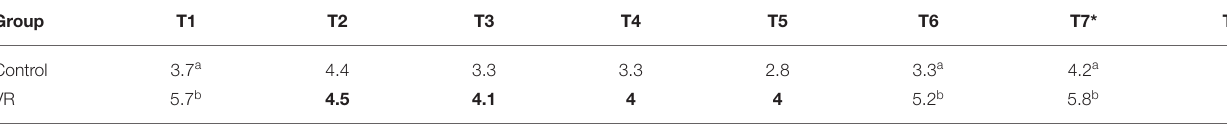
TABLE 2 | Raw pain ratings collected throughout the tattoo process across groups. Group T1 T2 T3